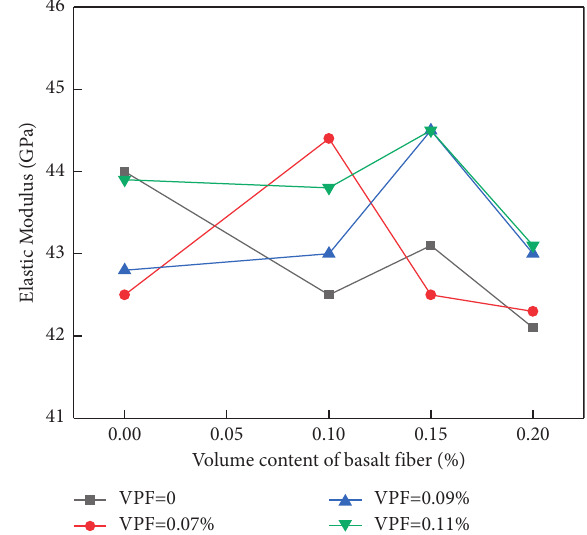
Figure 6: Splitting tensile strength effect of concrete with different fiber volume rate.